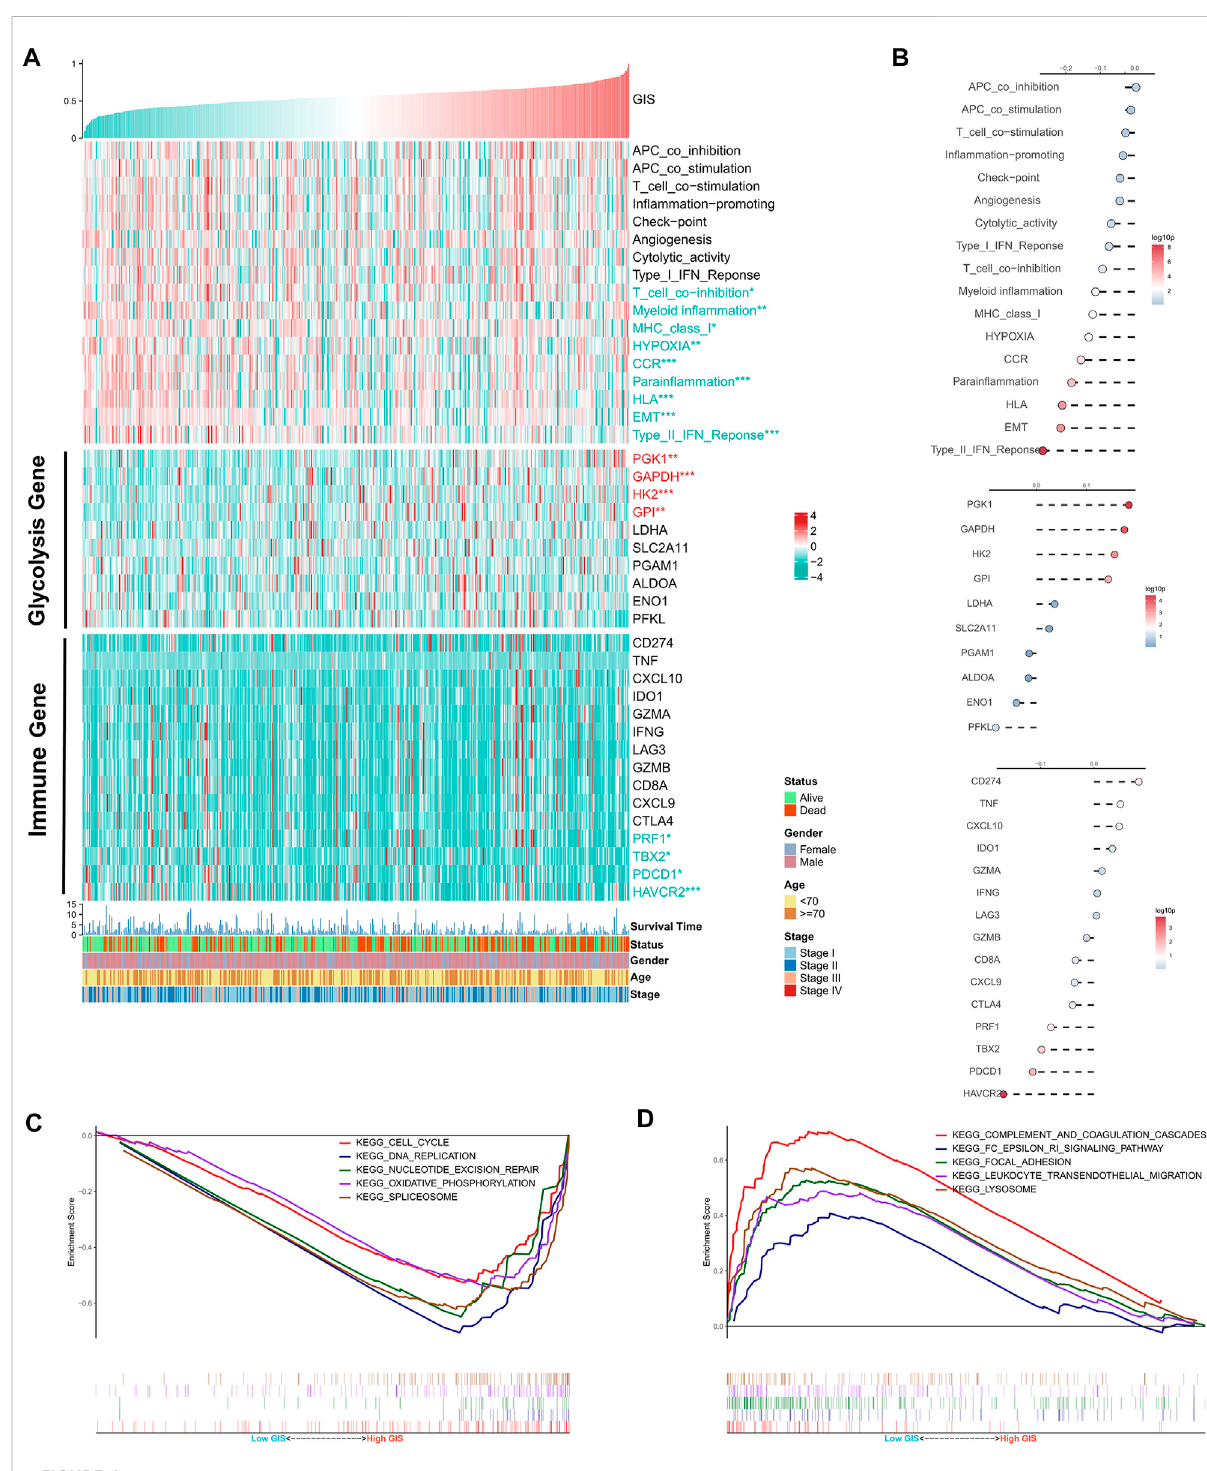
FIGURE 4 Functional analysis of the GIS risk model. (A) Heat maps of the correlations among GIS, biological pathway activity, glycolysis gene expression, immune gene expression, and clinical features. Red name with * represents upregulation in the high GIS group, and green name with * represents upregulation in the low GIS group; * p < 0.05, ** p < 0.01, *** p < 0.001. (B) Correlation analysis of GIS and biological pathway activity, glycolysis gene expression, and immune gene expression (top to bottom). (C) GSEA enrichment map shows the fi ve pathways of interest within the high GIS group. (D) GSEA enrichment map shows the fi ve pathways of interest within the low GIS group. GIS, glycolysis – immune score; GSEA, gene set enrichment